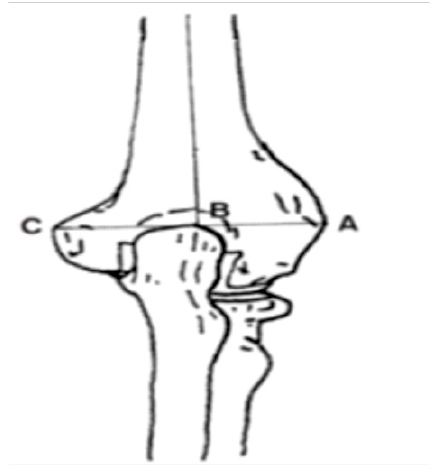
Figure 1: Calculating the lateral condylar